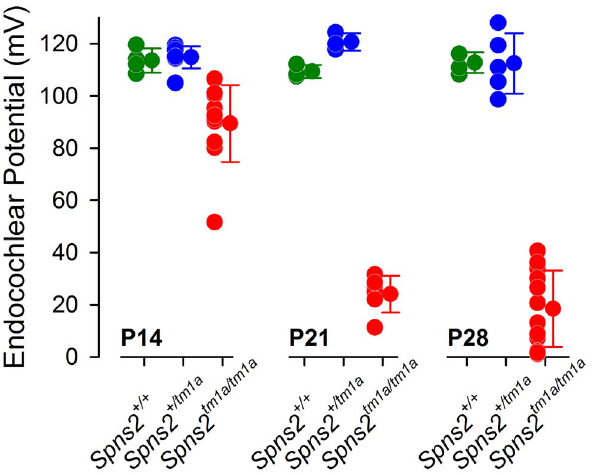
Figure 4. Endocochlear potential (EP) showed a progressive reduction from P14 to P21. Control mice had normal EP magnitudes of around 99–120 mV at P14 ( Spns2 + / + , n=4; Spns2 + /tm1a , n=9), P21 ( Spns2 + / + , n=3; Spns2 + /tm1a , n=3) and P28 ( Spns2 + / + , n=4; Spns2 + /tm1a , n=5). The Spns2 tm1a/tm1a mice showed a significant reduction in the EP magnitude at P14 (n=11; p , 0.001), P21 (n=6; p=0.002) and P28 (n=12; p , 0.001) compared to age-matched control values (Mann- Whitney Rank Sum Test; SigmaPlot v12.0). There was a large drop in the EP values in Spns2 tm1a/tm1a mice between P14 and P21.